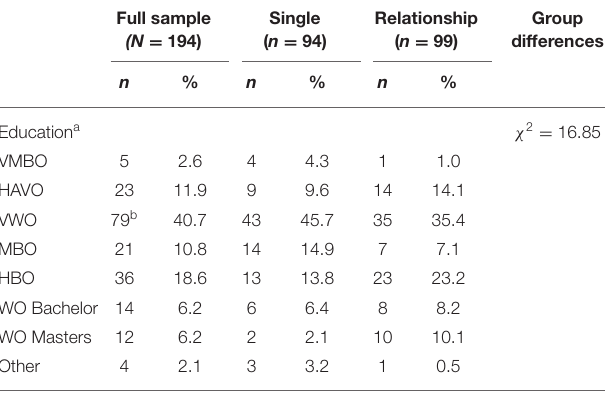
TABLE 3 | Education level in Study 2 (Main